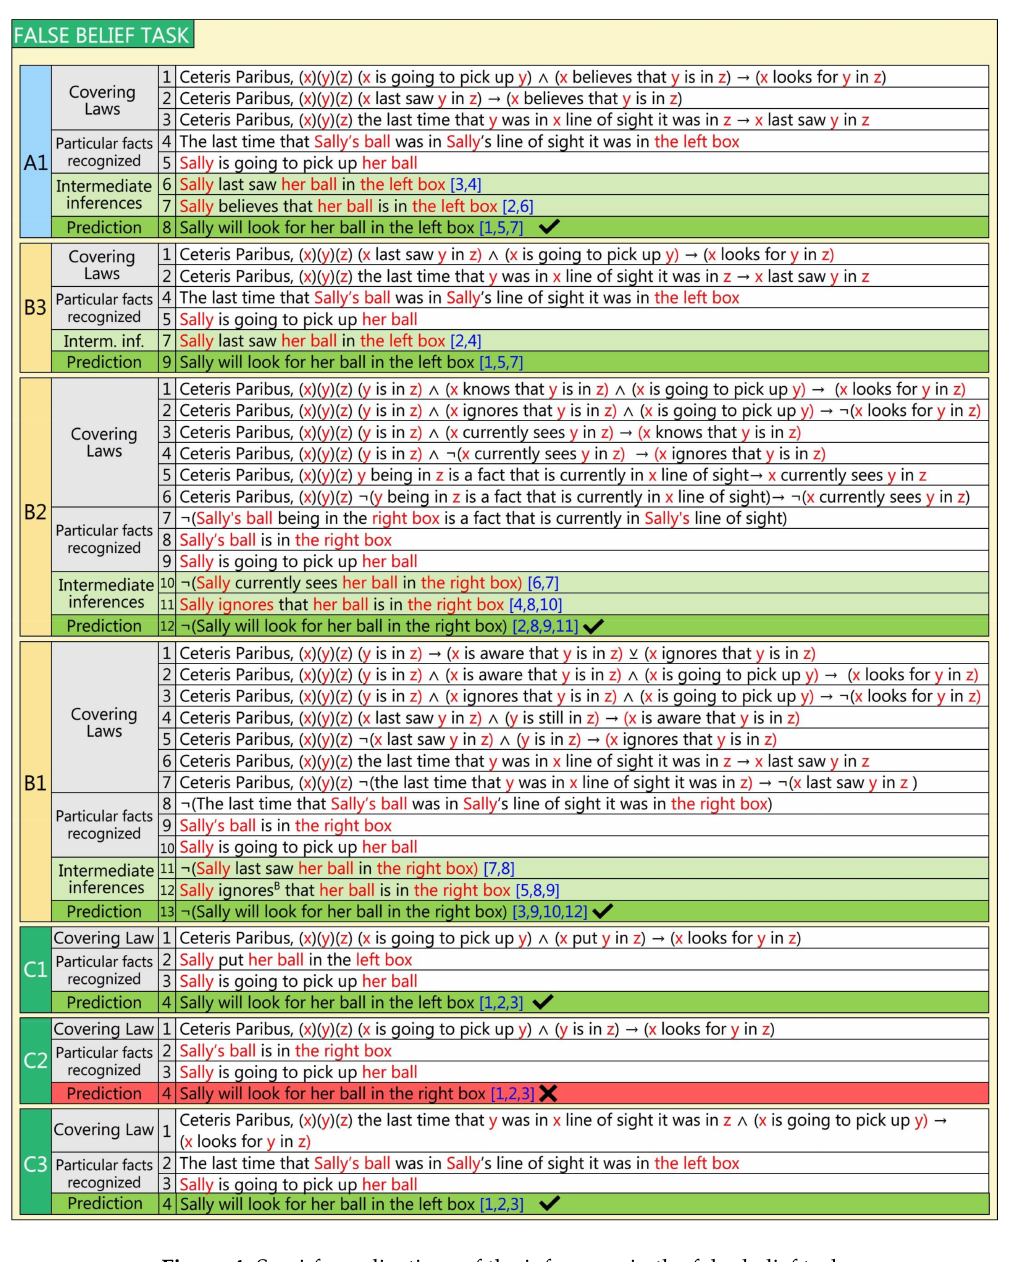
Figure 4. Semi-formalizations of the inferences in the false belief